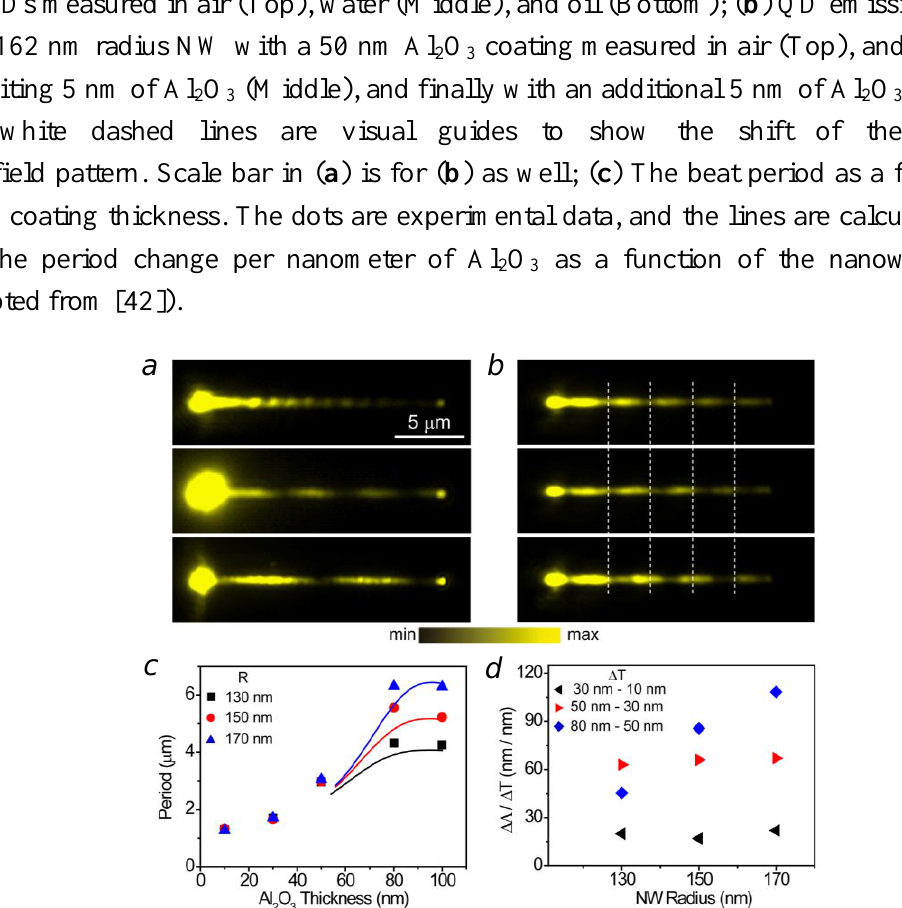
O 2 3 O (Bottom). 2 3